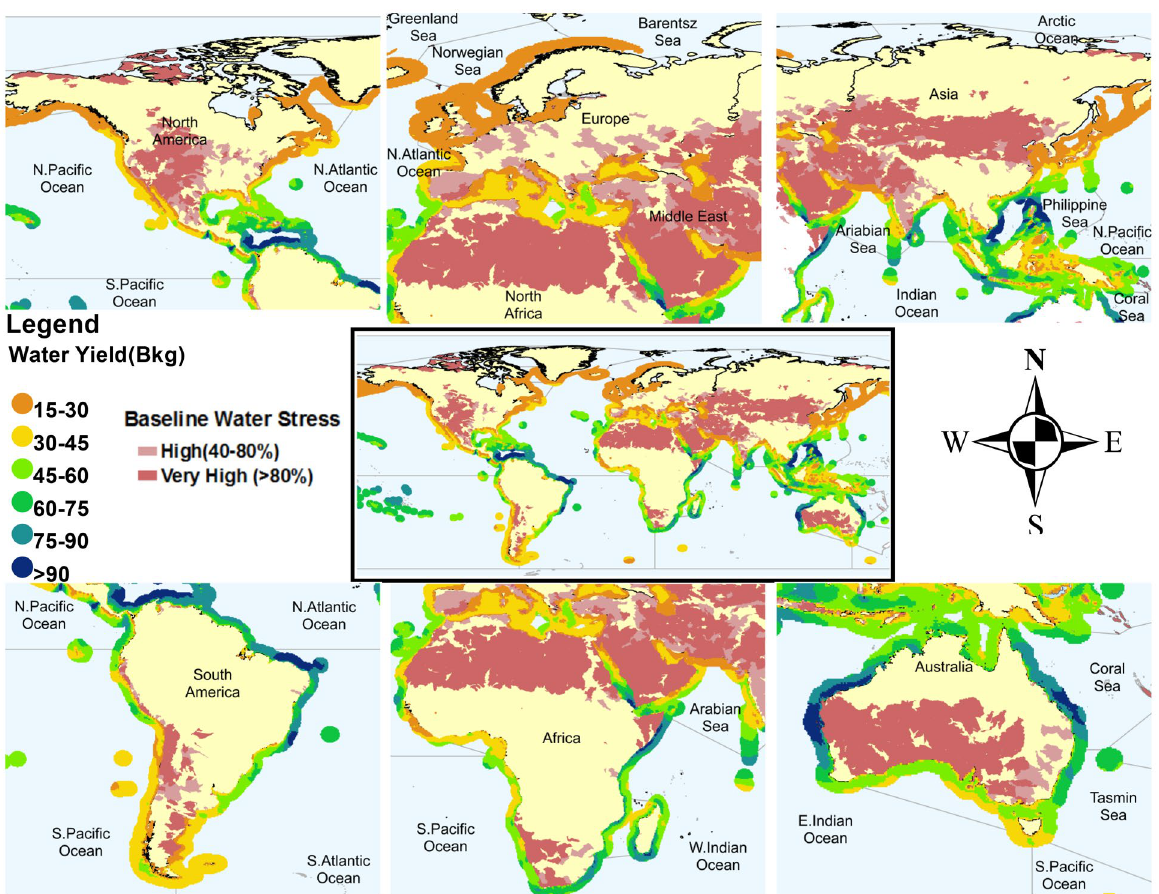
Figure 3. Spatial variability of water yield along the delineated near-offshore region of 200 km across the world. The colors represent the annual potential water yield in billion kgs.The output stands for a hypothetical intake of 100 m in height and 210 m in width. [Figures created using Python script and composited with Microsoft Publisher 365